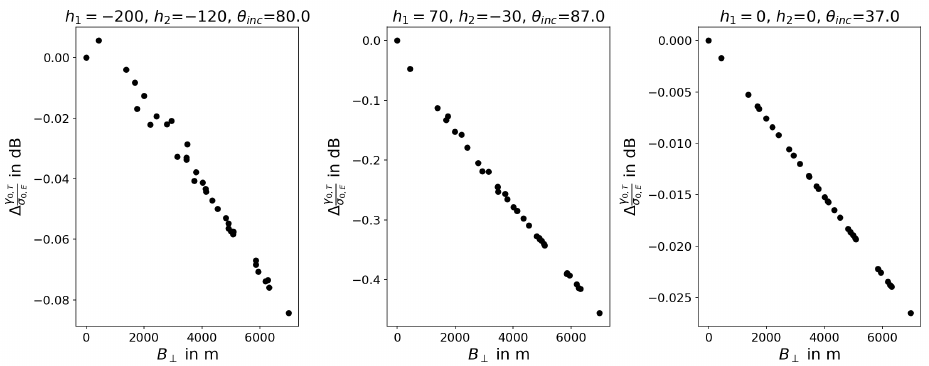
Figure 6. Scatter plot of ∆ A γ in dB vs. perpendicular baseline ( B ⊥ ) corresponding to ALOS stack 0, T used in Section 3.2 for three different facets. The values of h 1 and h 2 for the facet, along with the resulting local incidence angle θ inc are also